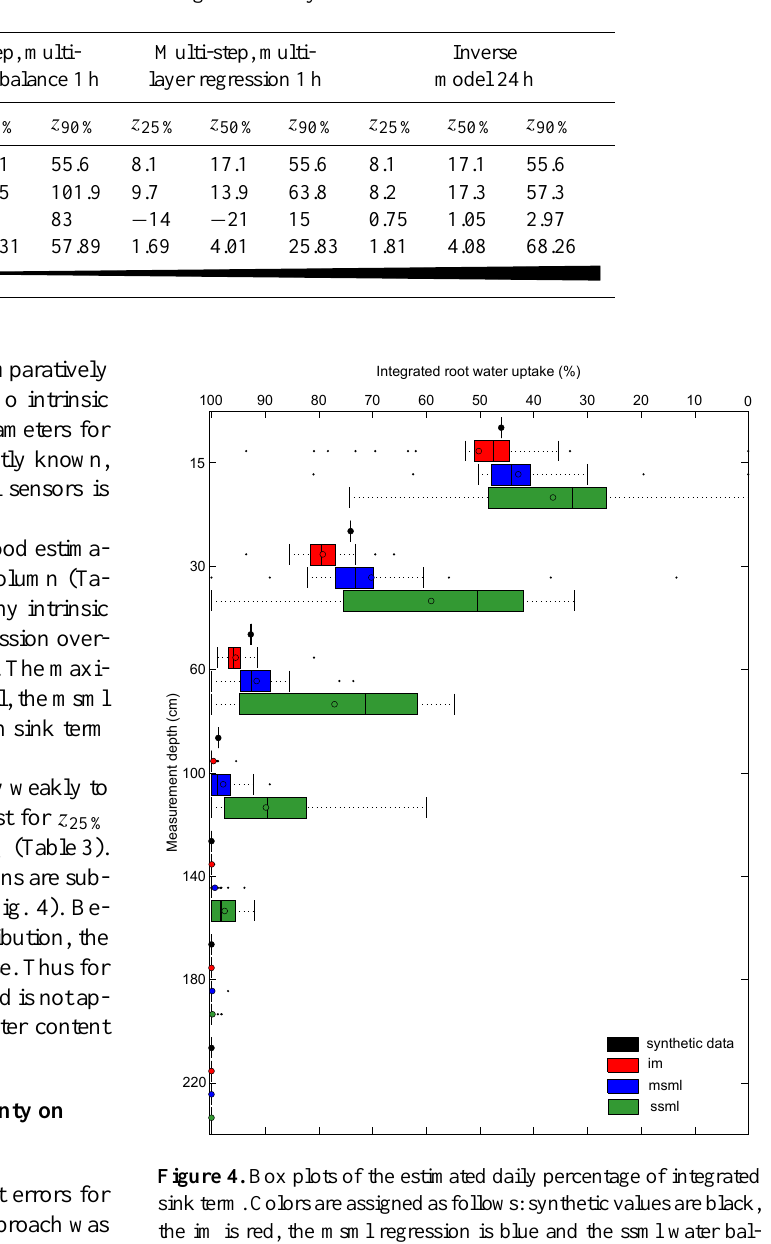
relative bias and (cid:1871)̃ is the standard deviation of the estimated values. Larger width of the black arrow 886